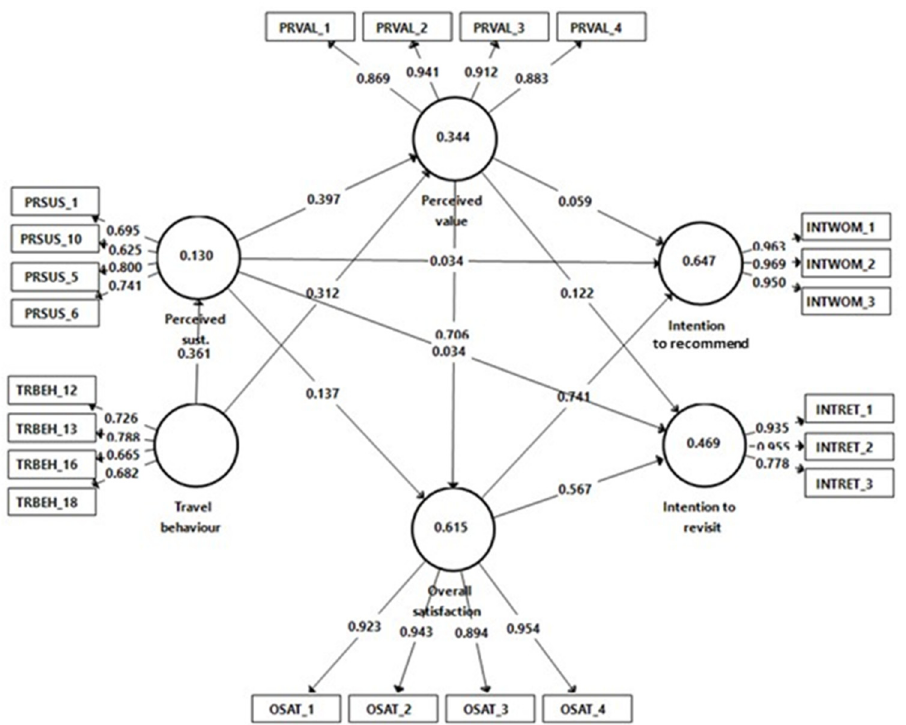
Figure 2. Conceptual Model with PLS results.